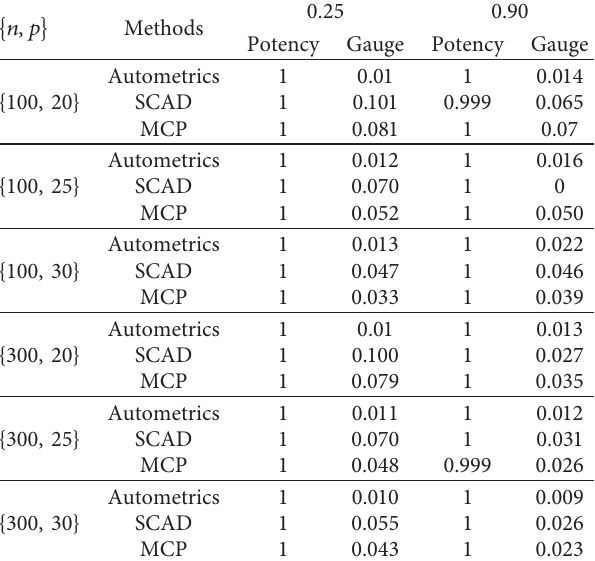
Table 2: Simulation results for gamma distributed